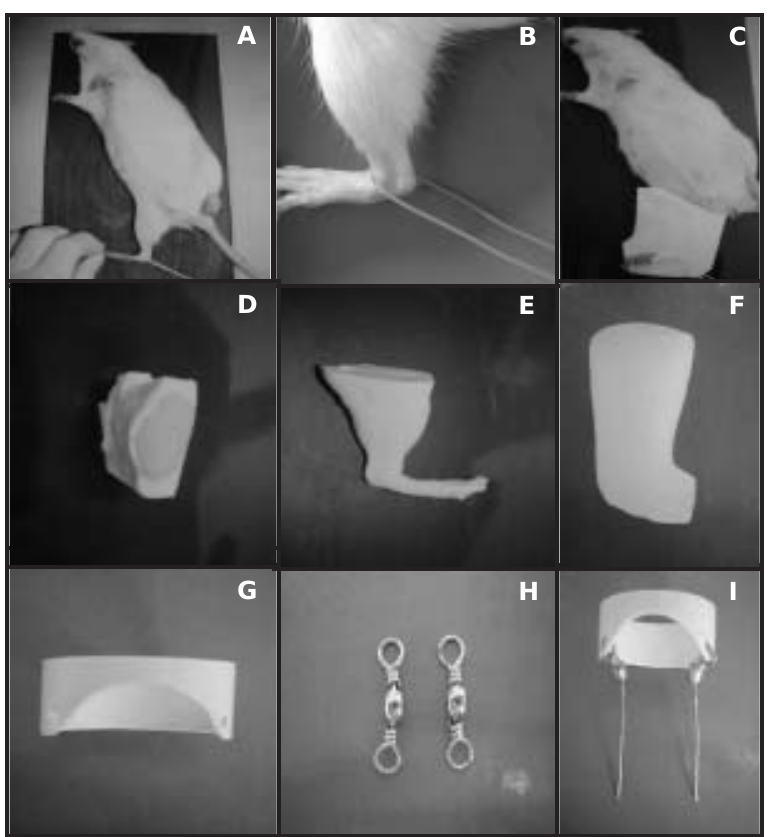
Figure 1. Sequence of the process or orthosis preparation. A and B , positioning of the ankle joint in a neutral position; C , limb molding with potassium alginate; D , placement of the plaster in the alginate mold; E , plaster mold; F , acrylic resin model; G , abdominal belt; H , supports; I , bilateral supports coupled to the abdominal belt.